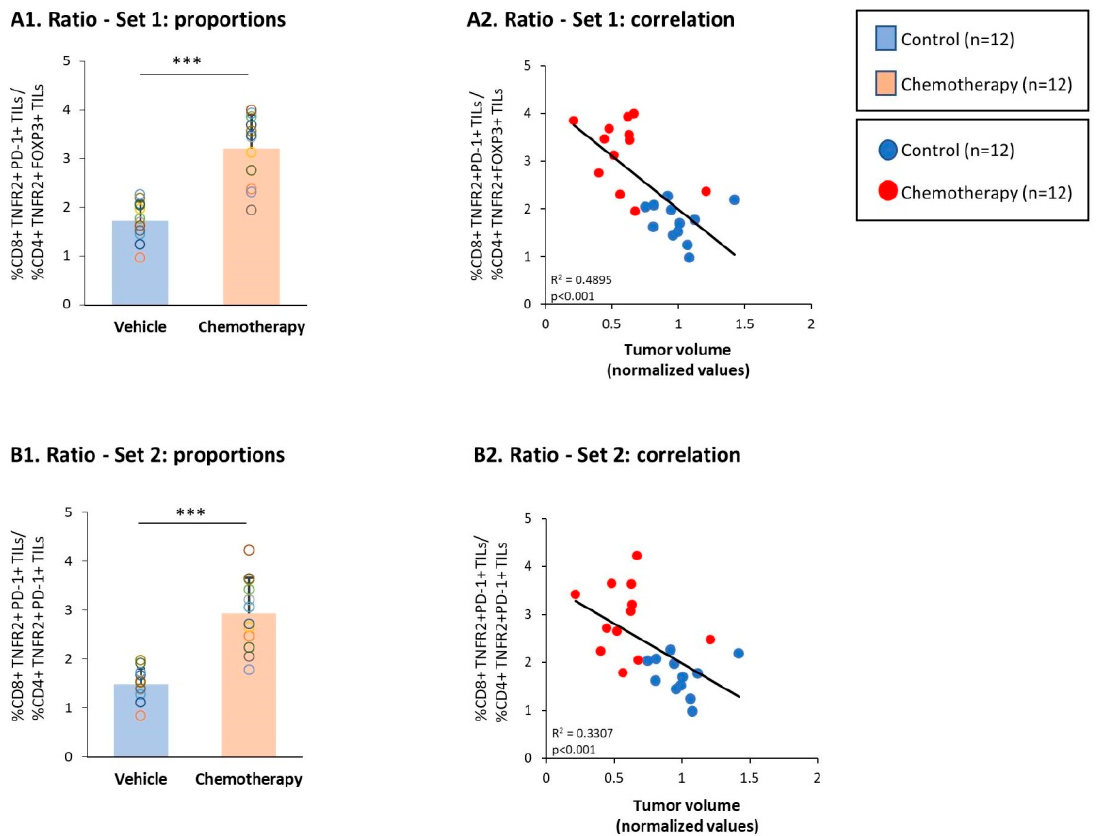
Figure 6. Chemotherapy increased the proportion of CD3+ TNFR2+ PD-1+ TILs at the expense of CD4+ TNFR2+ FOXP3+ and CD4+TNFR2+ PD-1+ TILs. Murine 4T1 TNBC cells were syngrafted to BALB/c mice in the presence of chemotherapy or a vehicle control; procedures and analyses were performed as described in Figure 3. ( A ) Ratio—set 1: ratio between CD8+ TNFR2+ PD-1+ TILs and CD4+ TNFR2+ FOXP3+ TILs. ( A1 ) Ratio of CD8+ TNFR2+ PD-1+ TILs over CD4+ TNFR2+ FOXP3+ TILs, calculated on the basis of the percentages of the two subsets in each mouse. ( A2 ) The ratio of CD8+ TNFR2+ PD-1+ TILs over CD4+ TNFR2+ FOXP3+ TILs, correlated with tumor volumes. ( B ) Ratio—set 2: ratio between CD8+ TNFR2+ PD-1+ TILs and CD4+ TNFR2+ PD-1+ TILs. ( A1 ) Ratio of CD8+ TNFR2+ PD-1+ TILs over CD4+ TNFR2+ PD-1+ TILs, calculated on the basis of the percentages of the two subsets in each mouse. ( A2 ) The ratio of CD8+ TNFR2+ PD-1+ TILs over CD4+ TNFR2+ PD-1+ TILs, correlated with tumor volumes. In the proportion and correlation analyses, the average value of the vehicle-treated group in each biological repeat was given the value of 1 and the values of all mice analyzed in that repeat were normalized accordingly. The value of each mouse is presented as a dot. *** p < 0.001 (two-tailed unpaired Student’s t -test; correlation analyses: Pearson;